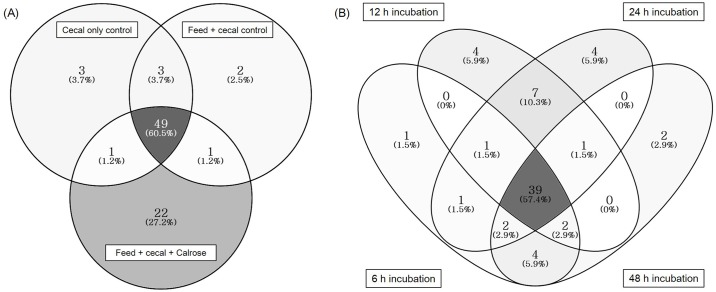
Distribution of bacterial taxa in genus level in sample groups.(A: controls and treatment, B: incubation time).